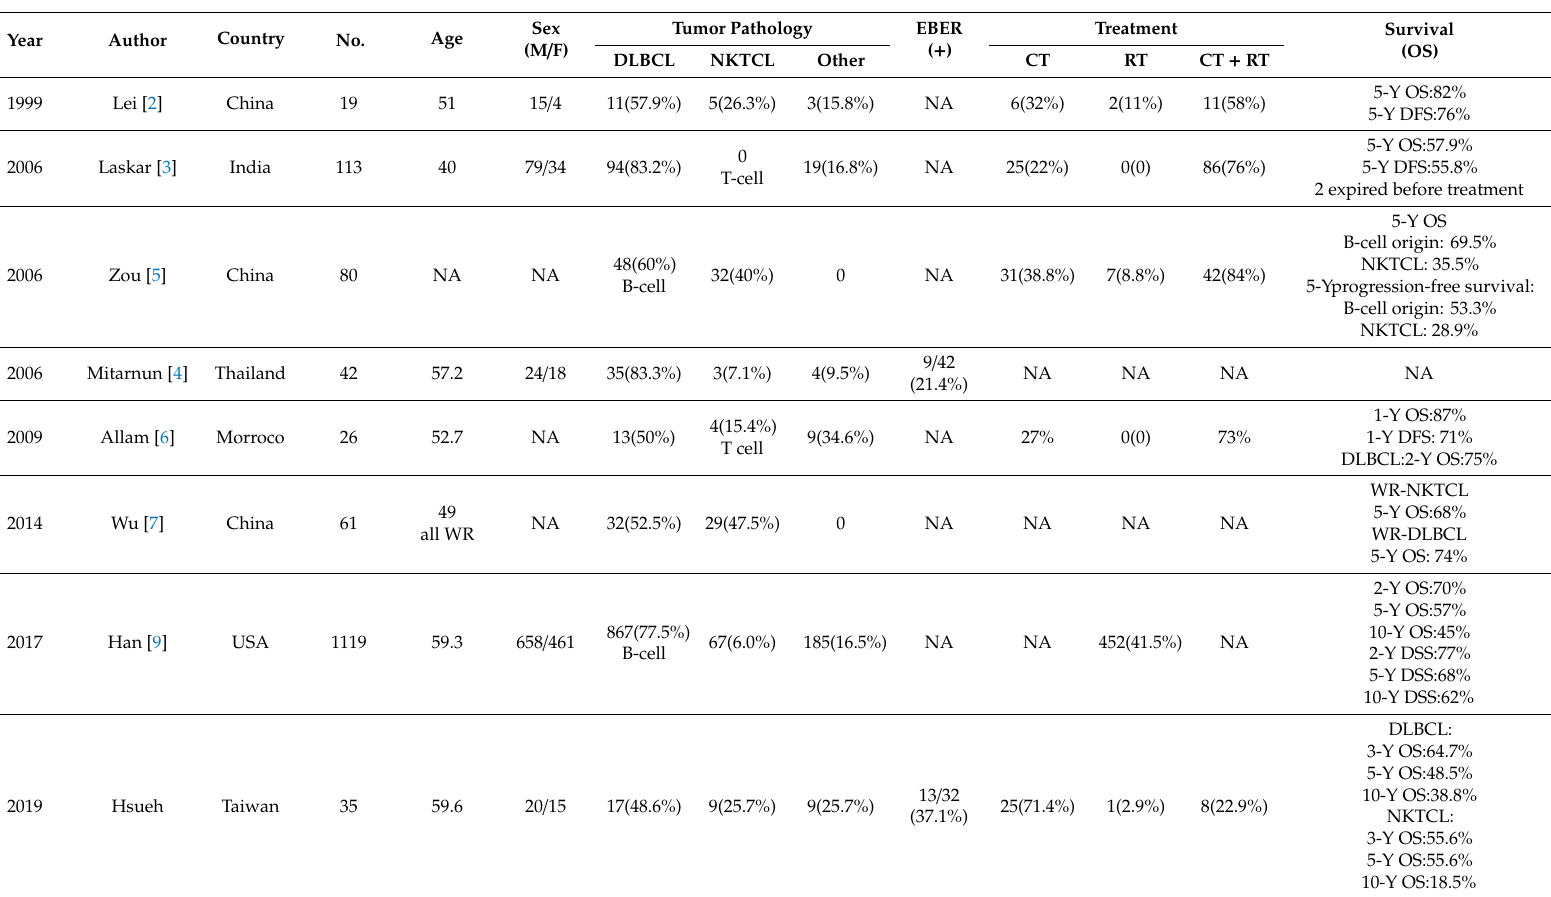
Table 3. Summary of studies of NP